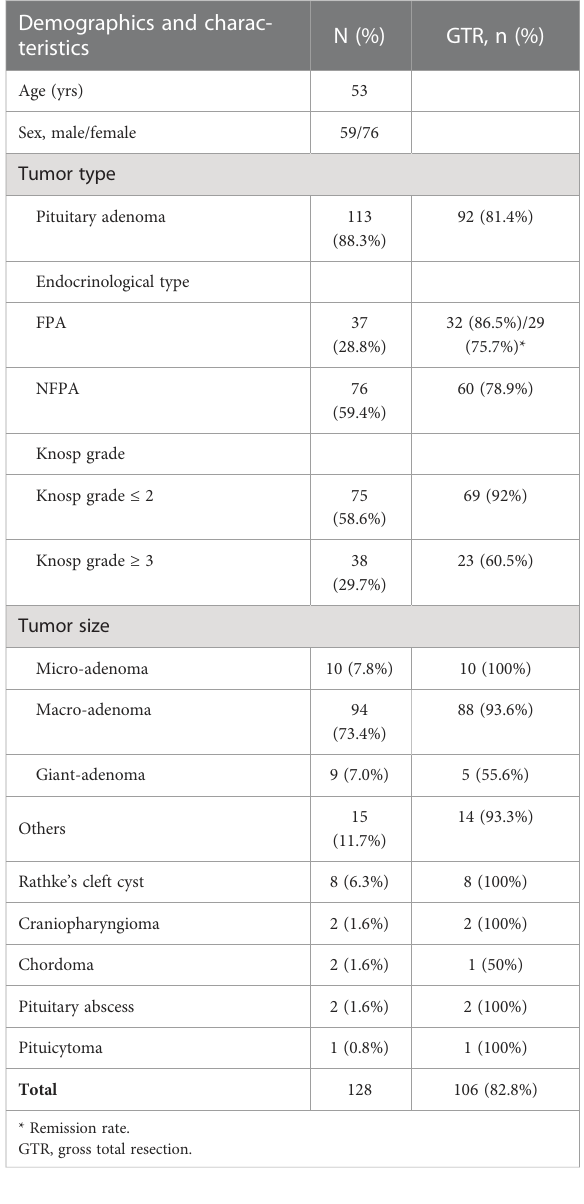
TABLE 1 Patient characteristics and the tumor resection